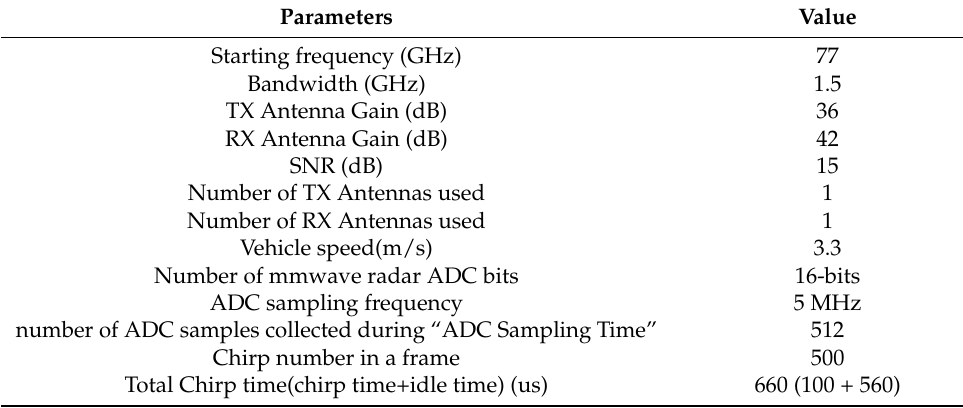
Table 2. Experiment setting